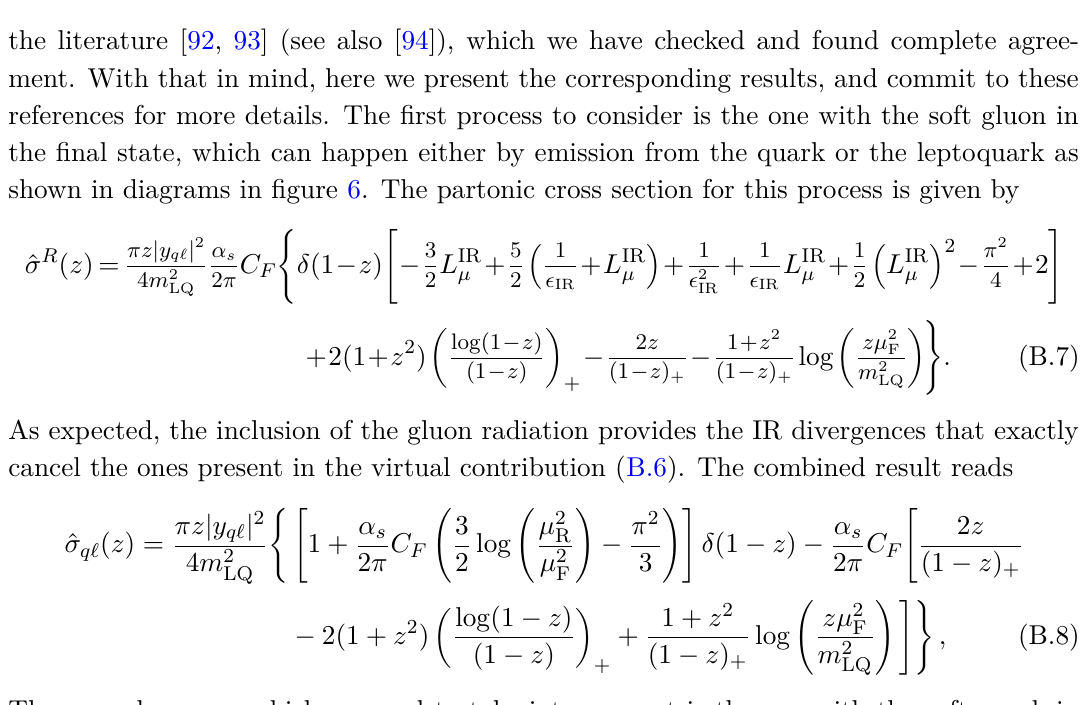
Figure 7 . Diagrams for the process g + ‘ → q + LQ contributing to the resonant leptoquark production at O ( α s )